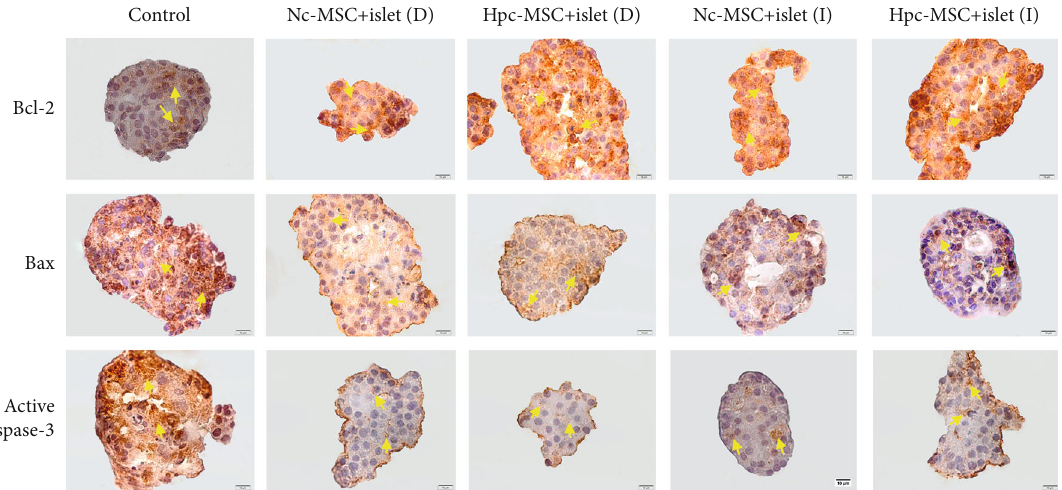
Figure 4: Immunocytochemistry of Bcl-2, Bax, and active caspase-3 in human islets cocultured with WJ-MSCs. The signi fi cant enhancement of Bcl-2 and reduction of Bax and active caspase-3 protein levels in the cocultured islets with Hpc-MSCs and Nc-MSCs (yellow arrows show positive protein expression). Scale bar: 10 μ m. WJ-MSCs: Wharton ’ s jelly-derived mesenchymal stem cells; Nc-MSCs: normoxia condition MSCs; Hpc-MSCs: hypoxia preconditioning MSCs; D: direct coculture; I: indirect